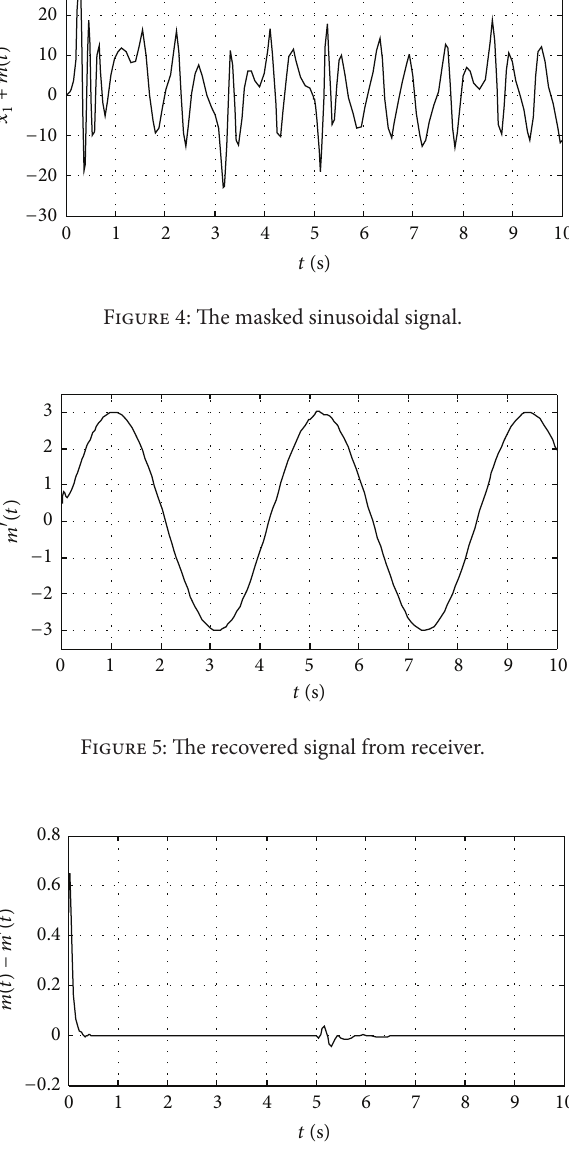
Figure 6: The error curve between plaintext and recovered